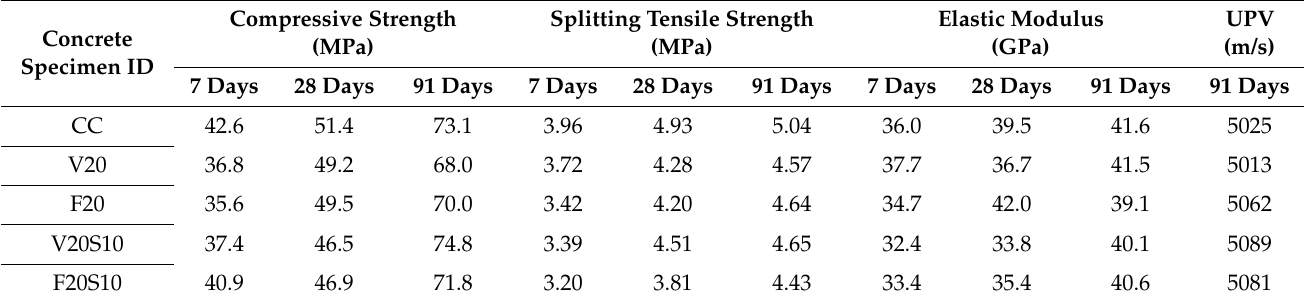
Table 5. Mechanical properties of concrete with respect to aging before elevated temperature exposure and UPV.